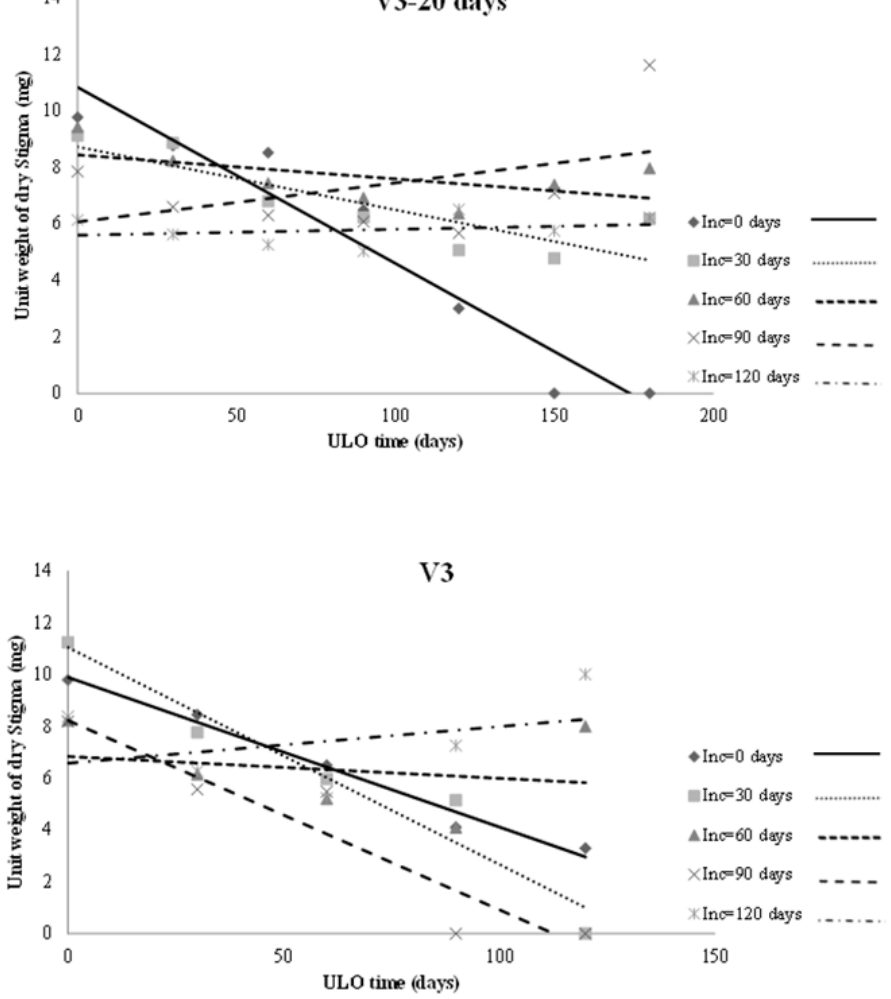
Figure 3. Graph of the unit weight of dry stigma (mg) for different incubation times during the ULO storage, for the different vegetative stages studied (V3–20 d and V3).